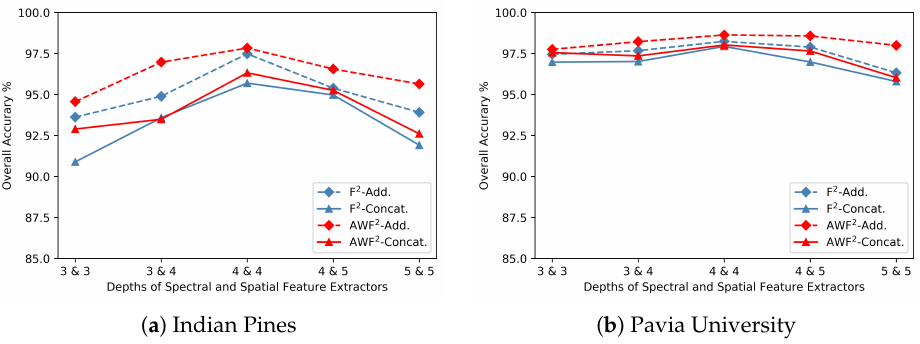
Figure 11. Overall accuracies for different depths of the two feature extractors (3 & 3, 3 & 4, 4 & 4, 4 & 5, and 5 & 5, respectively). ( a ) On the Indian Pines dataset, and ( b ) on the Pavia University